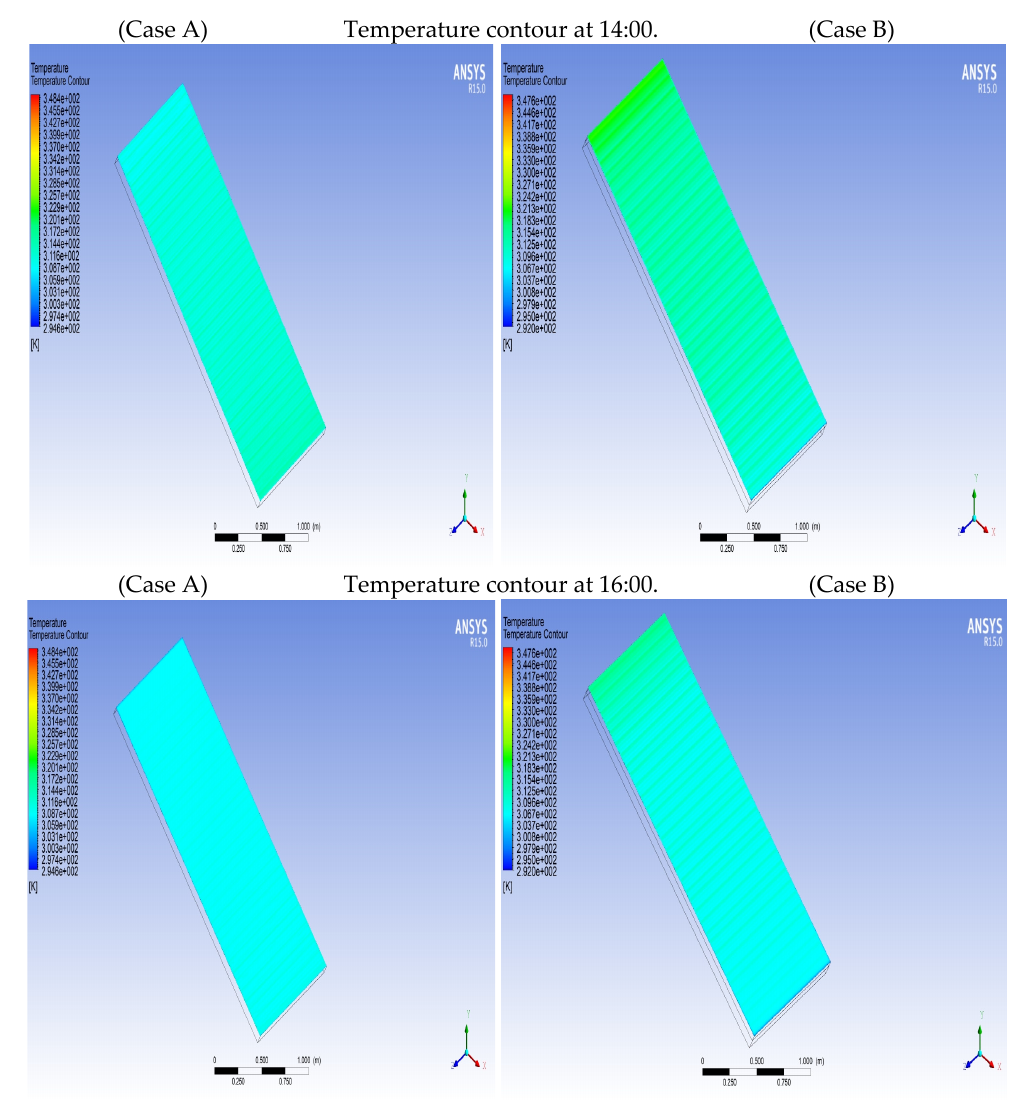
Figure 11. The temperature contours of the upper glass cover at various time intervals.